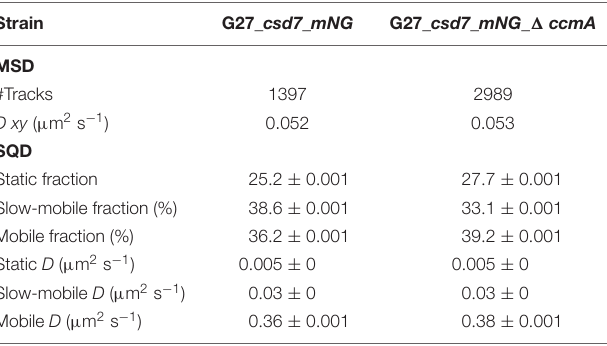
TABLE 4 | Summary of Csd7_mNG single-molecule dynamics in H. pylori G27. Strain